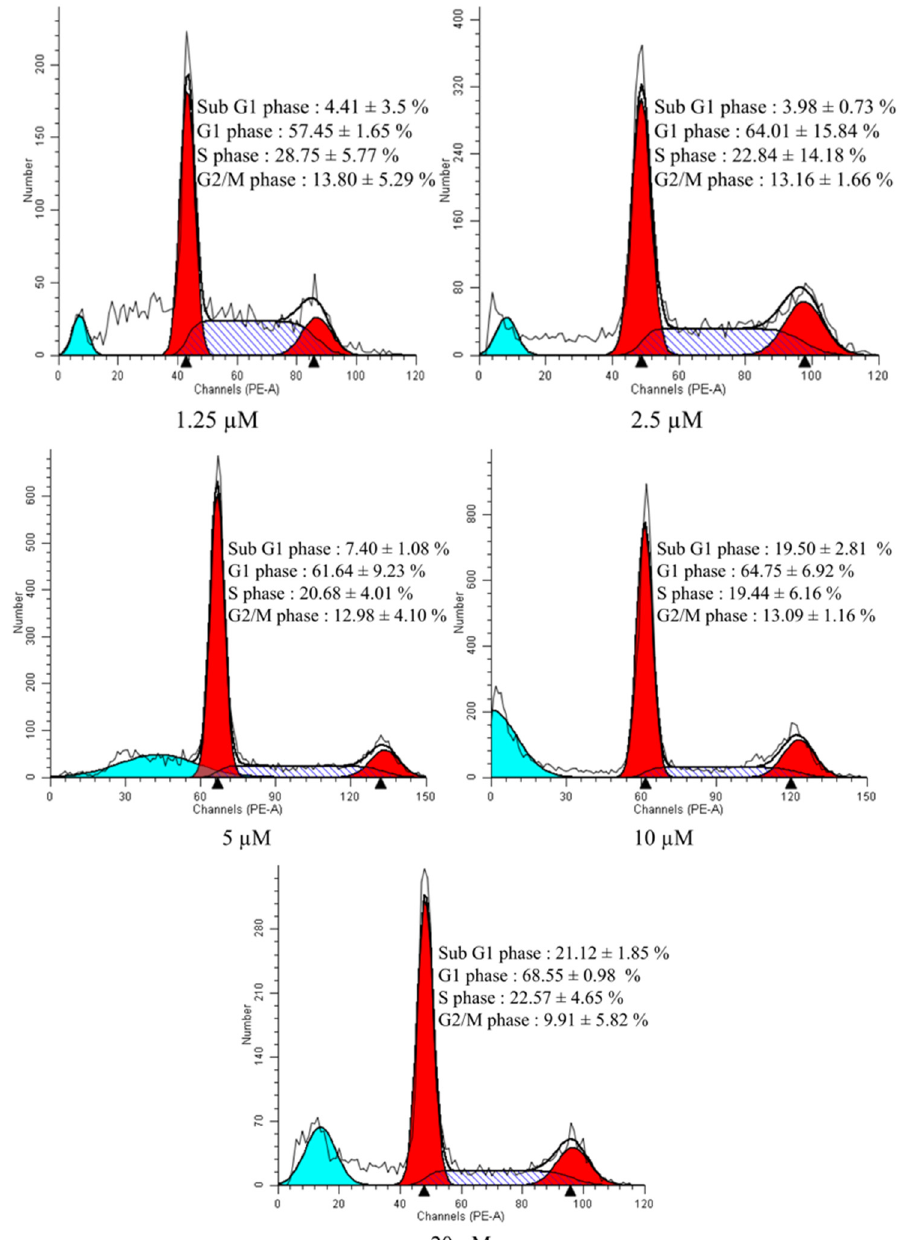
Figure 3 . Effect of curcuminoids (i.e., curcumin and DMC) on the cell cycle distribution of HUVECs. ( A ) The cell-cycle distributions were analyzed in the HUVECs treated with curcumin. The cells were treated with several concentrations (0, 0.625, 1.25, 2.5, 5, and 10 μ M) of curcumin for 72 h, and flow cytometry was used to analyze cell cycle distributions. ( B ) The cell cycle distributions were assessed in the HUVECs administered with DMC. The cells were administered with several different concentrations (0, 0.625, 1.25, 2.5, 5, 10, and 20 μ M) of DMC for 72 h, and cell cycle distributions were analyzed by flow cytometry. * p < 0.05 and ** p < 0.01 compared to the control group (treated with 10% FBS alone).